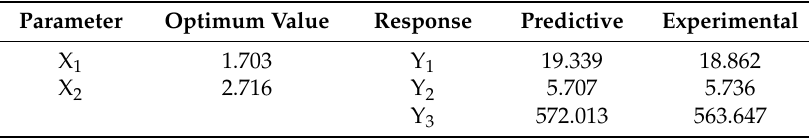
Table 7. Comparison of the predictive and experimental result optimum values.